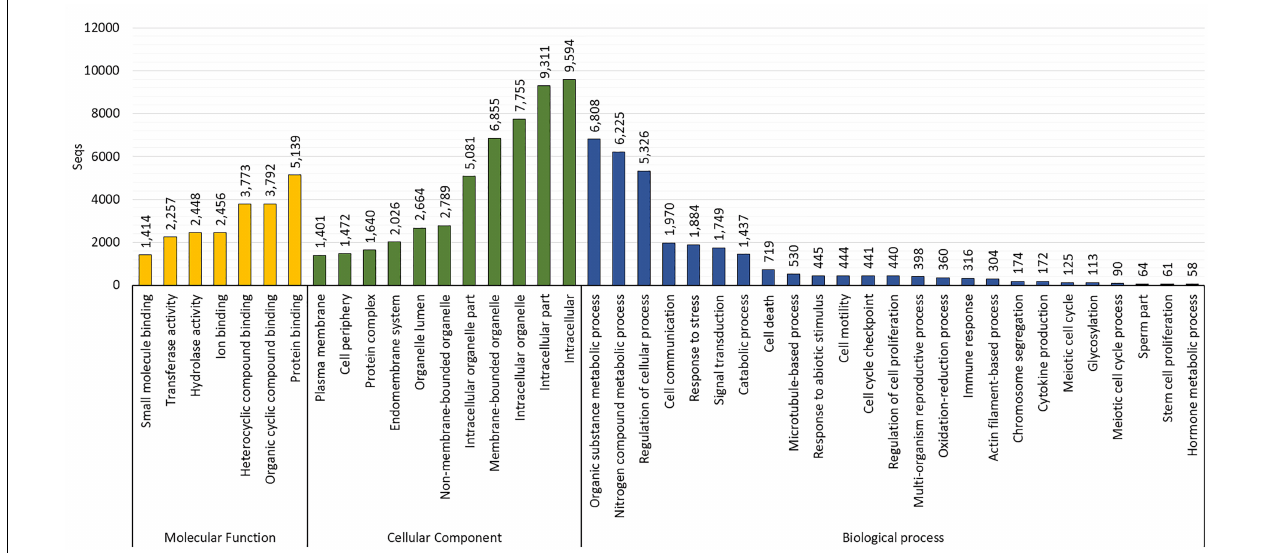
FIGURE 3 | Gene ontology (GO) distribution by category at level 3 in the reference testis transcriptome of O. maya males.